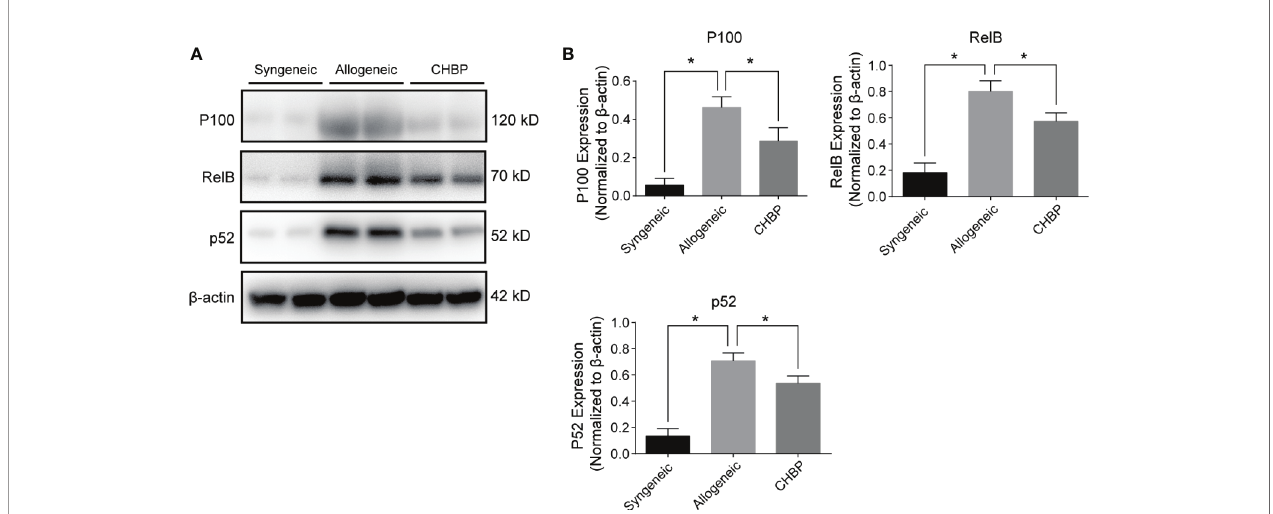
FIGURE 5 | CHBP inhibited NF- k B signaling pathway. (A) Representative western blot images of P100, RelB, P52, and b -actin in the syngeneic, allogeneic, and CHBP groups. (B) Ratios of P100, RelB, and P52 to b -actin. *P < 0.05.